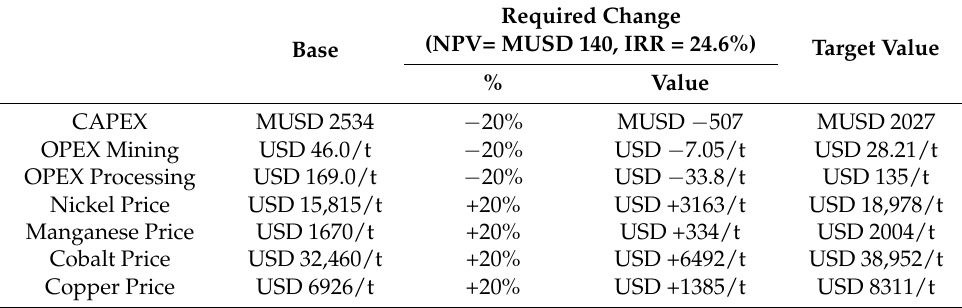
Table 14. Scenario of simultaneous change of key variables (HPAL technology).